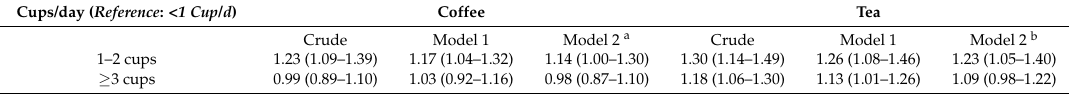
Table 3. Odds ratio for coffee or tea consumption and meeting physical activity guidelines ( n =